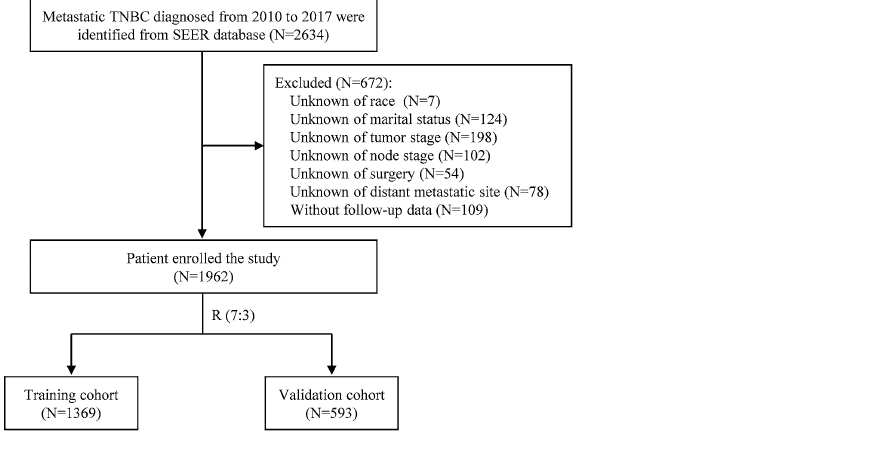
Figure 1. Flow chart of patient